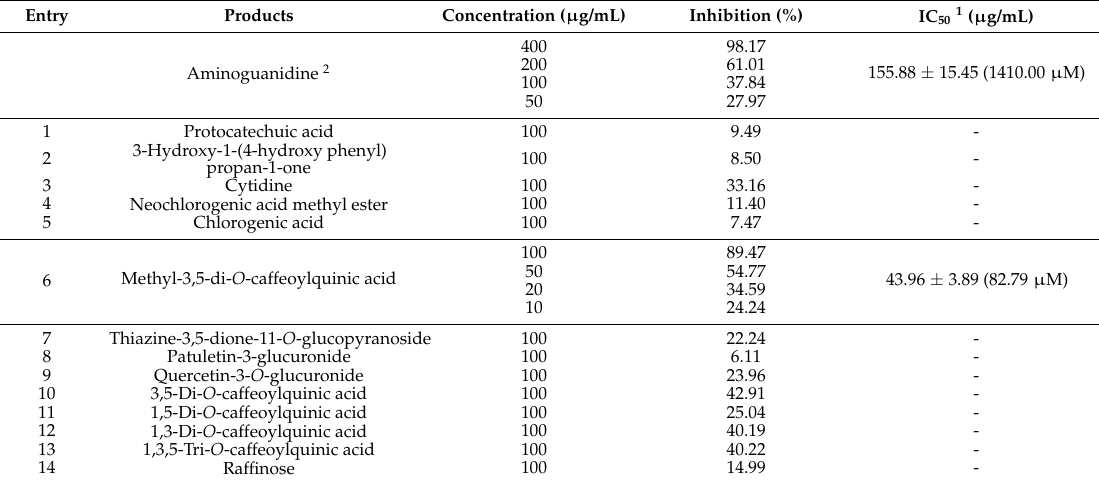
Table 5. Inhibitory effect of isolated compounds from X. strumarium on advanced glycation end products (AGEs).